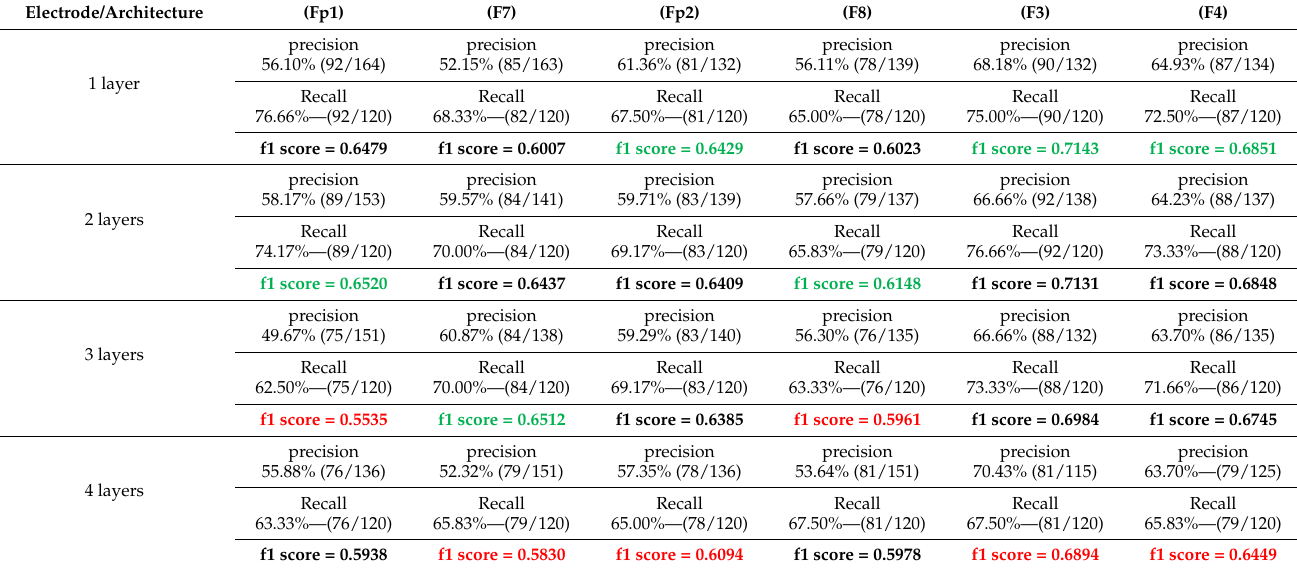
Table A4. The effect of model complexity on classification results—coordination task (f1 score is the measure by which we evaluate the quality of the model best model colored in green. The least successful model is marked in red). Electrode/Arc hitecture